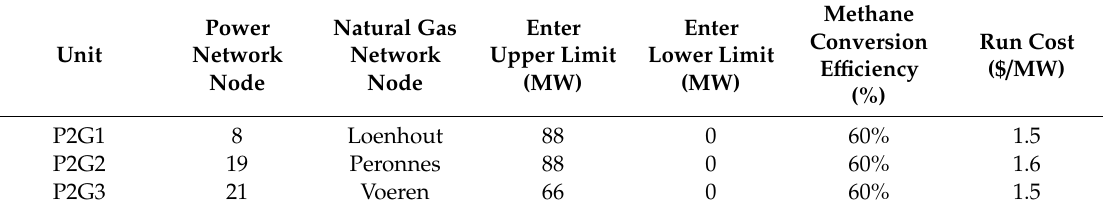
Table 2. P2G related parameters.